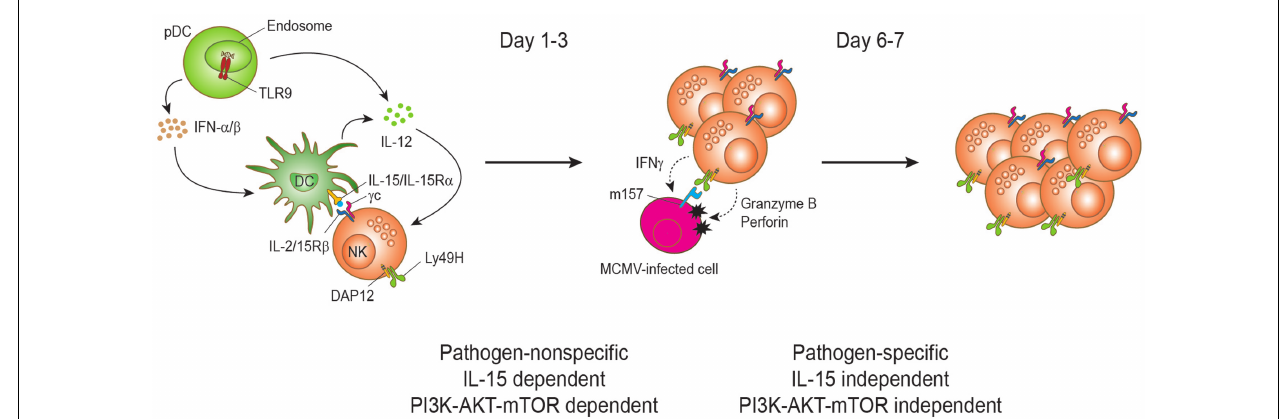
NK cells to induce proliferation and enhanced effector functions of NK cells. Activated NK cells can induce perforin/granzyme-mediated apoptosis of MCMV-infected cells by recognizing the viral m157 protein on the cell surface. This direct recognition depends on the activating receptor Ly49H. Proliferation at this stage is dependent on the PI3K–AKT–mTOR pathway. The interaction between Ly49H and the MCMV-encoded protein m157 drives the proliferation and expansion of Ly49H + NK cells on days 6–7 post infection. Notably, this proliferation can occur in IL-15- and IL-15R α -deficient mice during MCMV infection and is independent of the PI3K–AKT–mTOR